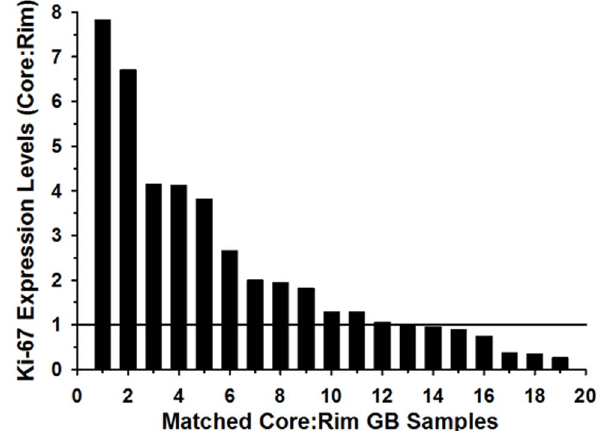
Figure 1. Ki-67 is overexpressed in GBM cells at the tumor core. From 19 independent GBM specimens, 1000 to 2000 stationary (core) and invasive (rim) cells were harvested by LCM for microarray analysis. Relative Ki-67 mRNA signal intensity was expressed as a ratio of rim to core.